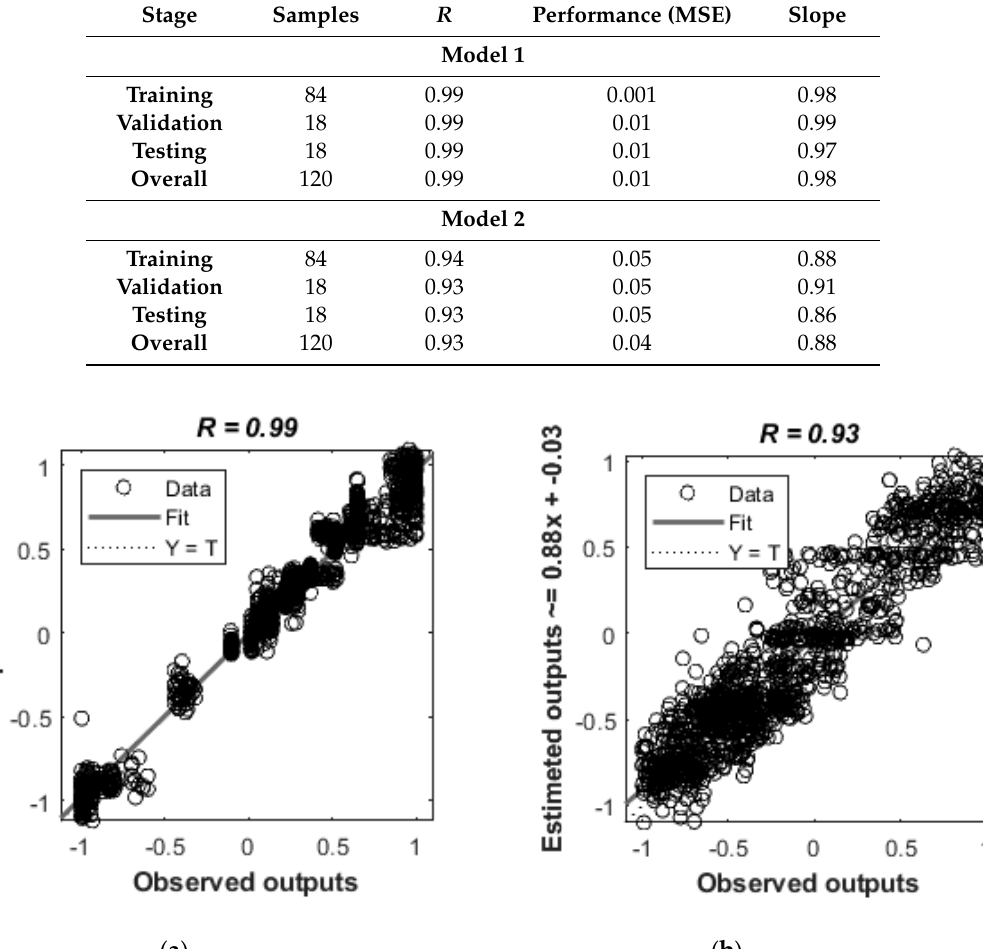
Table 2. Statistical data showing the stage, number of samples, correlation coefficient ( R ), performance based on mean squared error (MSE), and slope for Model 1 and 2.